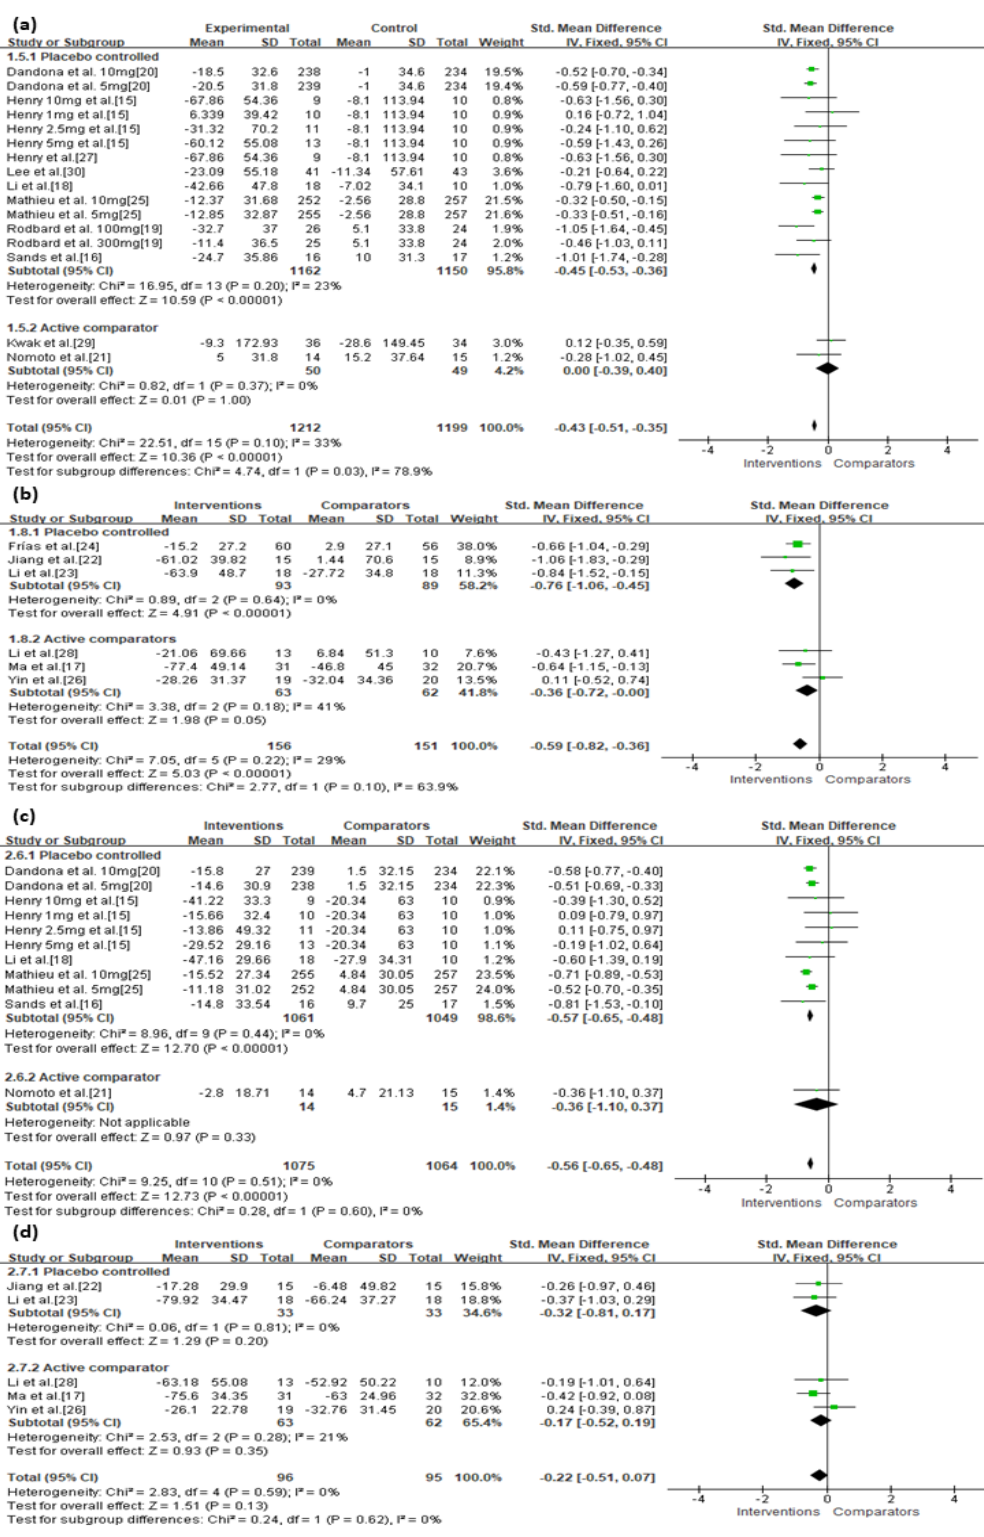
Figure 5. Effects of intervention on MAGE and MBG levels according to comparator type. ( a ) Evaluating MAGE with SGLT-2 inhibitor use; ( b ) evaluating MAGE with GLP-1 agonist use; ( c ) evaluating MBG with SGLT-2 inhibitors; ( d ) evaluating MBG with GLP-1 agonists. MAGE, mean amplitude of glycemic excursion; MBG, mean blood glucose; GLP-1, glucagon-like peptide 1; SGLT-2, sodium-glucose cotransporter 2. Green squares suggested measure of effect for each of included studies, and black diamond represented as meta-analyzed measure of effect. Bold letters indicated a category or subtotal of each subgroup and overall